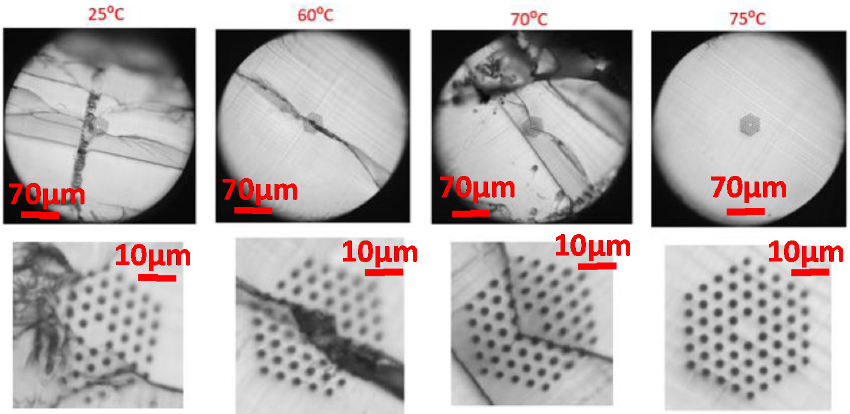
Figure 7. 4-ring mPOF end faces at different blade temperatures and 0.5mm/s blade cutting speed.